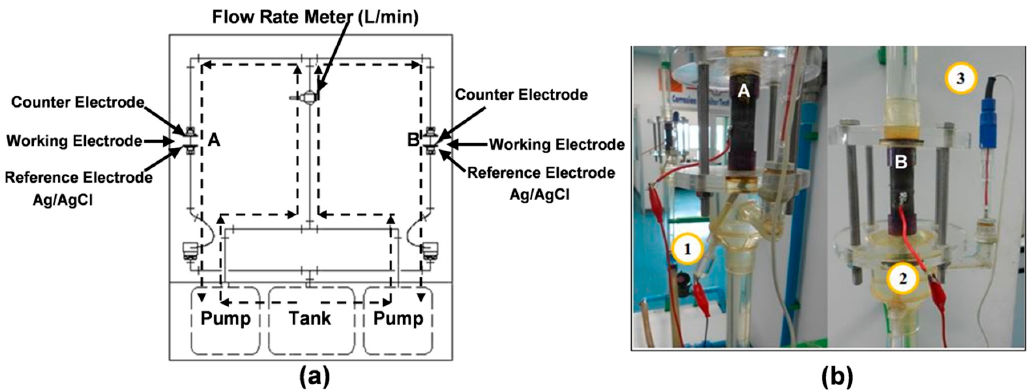
Figure 1. Corrosion testing circulator: ( a ) schematic model with flow directions (dashed lines) and ( b ) pipe specimens with connected electrodes: (1) counter electrode; (2) working electrode; (3) reference electrode.